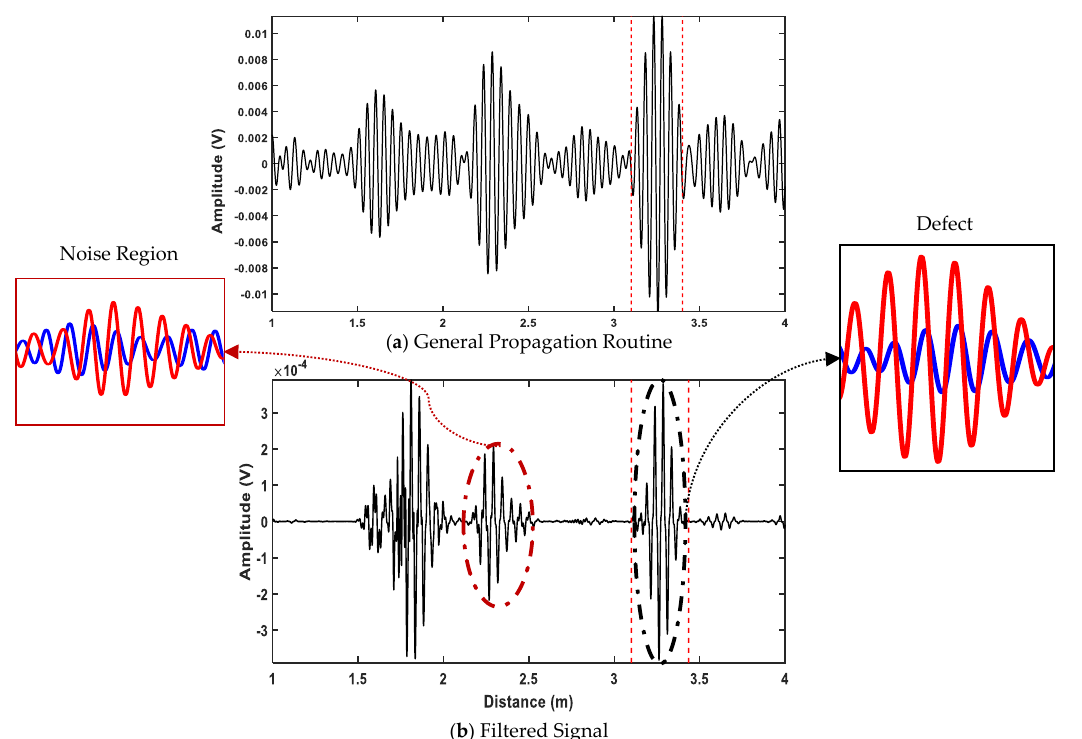
Figure 18. The result of ( a ) general propagation routine vs ( b ) filtered signal with their corresponding inputs (blue and red lines) of noise (left side) and defect (right side) with the excitation frequency of 34 kHz gathered from an experimental pipe with defect size of 3% CSA.